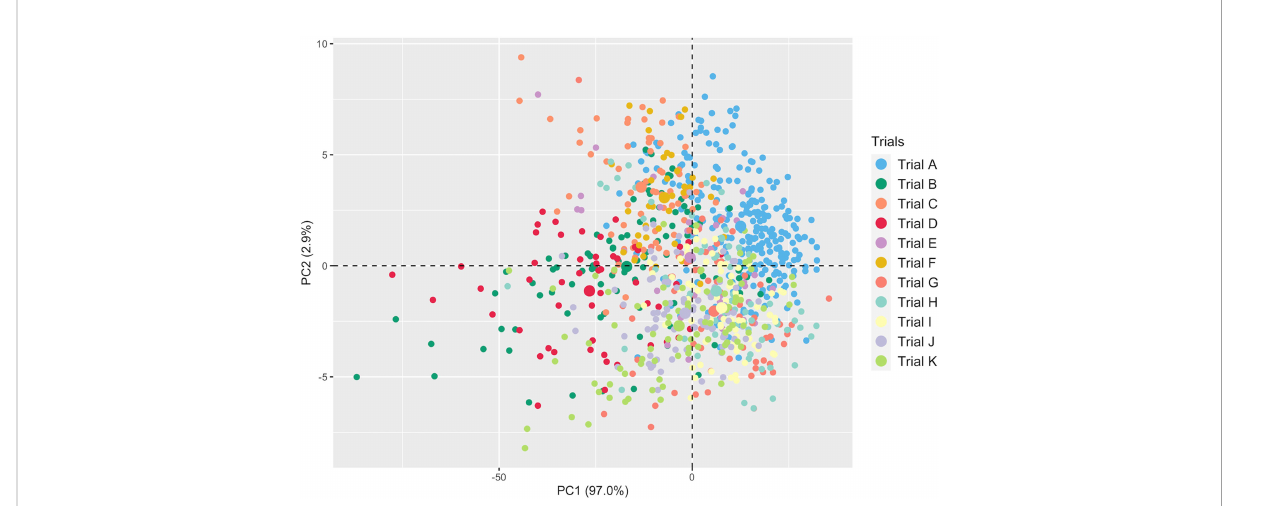
FIGURE 2 Principal component analysis of NIR spectral data from fresh cassava root scans captured with the